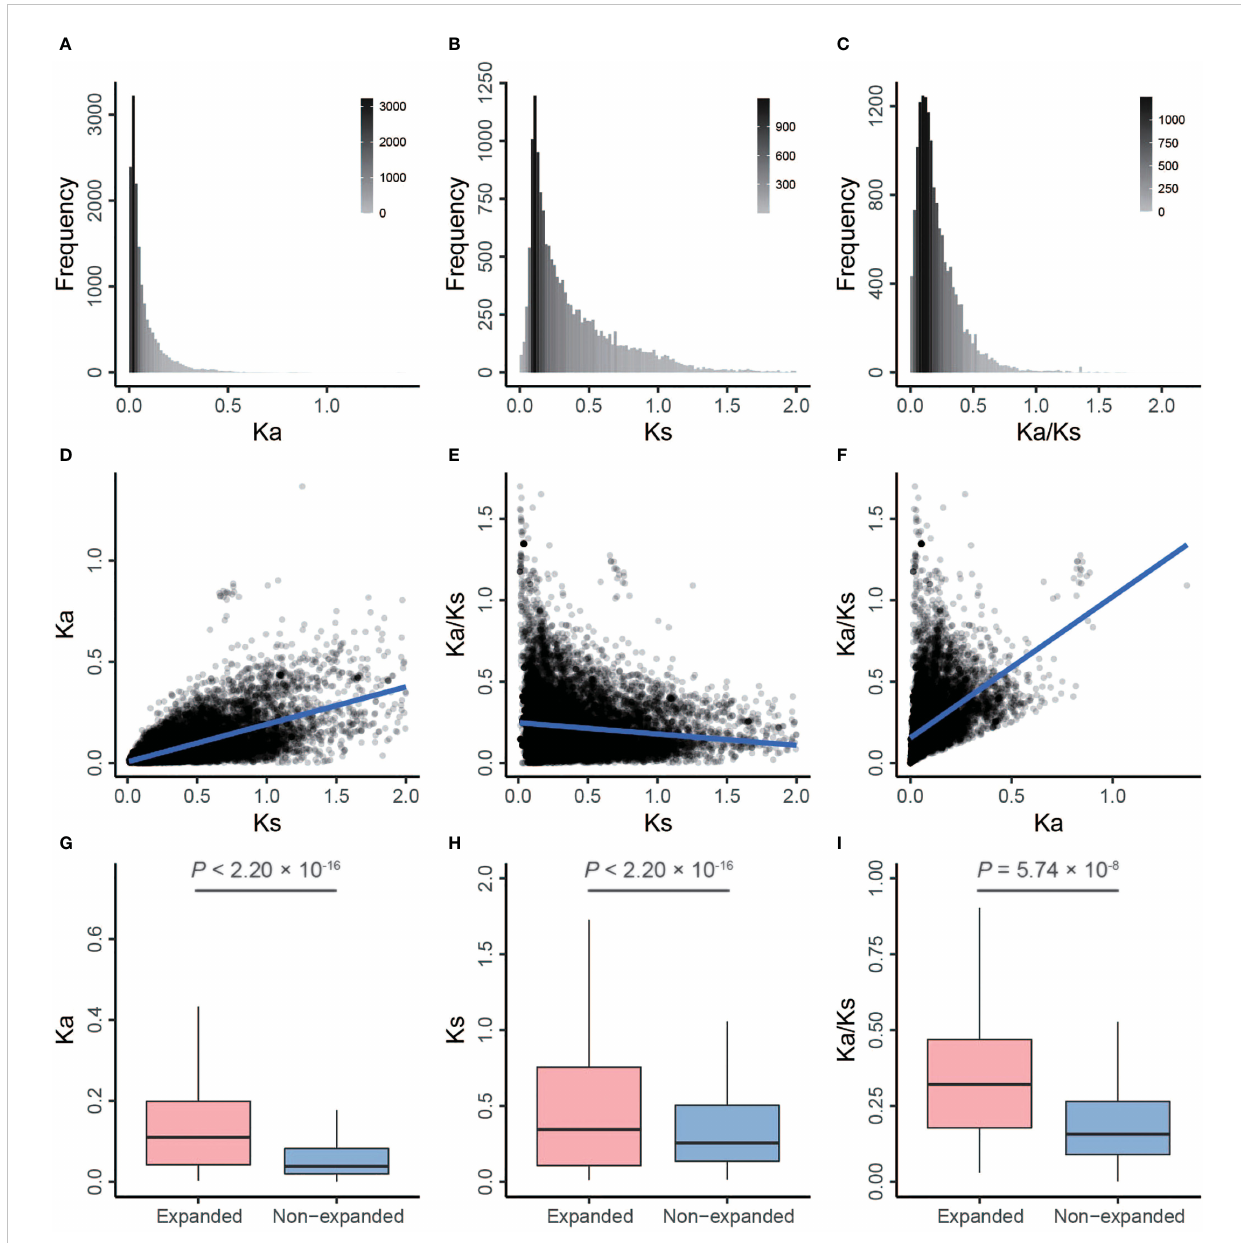
FIGURE 3 Distributions and correlation analysis of Ka, Ks, and Ka/Ks by comparing barley with rye. (A – C) The frequency distribution of Ka, Ks, and Ka/Ks, respectively. (D) The correlation between Ks (x-axis) and Ka. (E) The correlation between Ks (x-axis) and Ka/Ks. (F) The correlation between Ka (x- axis) and Ka/Ks. (G – I) The box plots of Ka, Ks, and Ka/Ks between expanded and non-expanded genes, respectively. The line in the box is the median value, and the lines at the bottom and top of each box are the fi rst (lower) and third (higher)